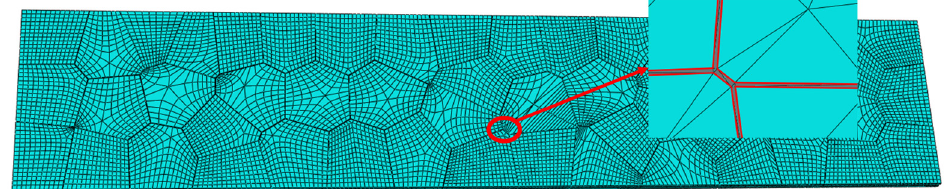
Figure 4. Three-dimensional Voronoi model and local magnification of grain boundaries.